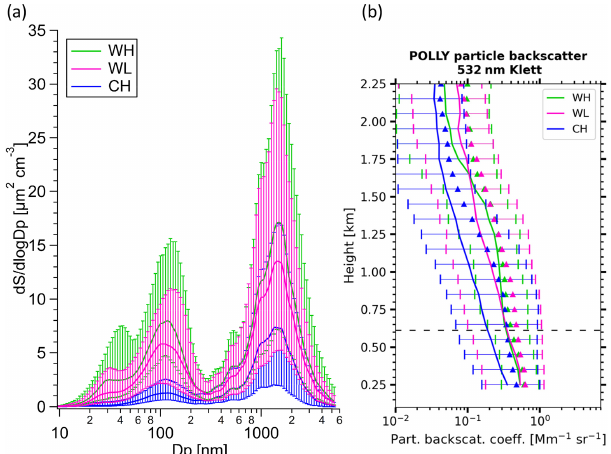
Figure 12. (a) Particle surface area size distribution for cold season high (CH, blue), warm season high (WH, green), and warm season low (WL, magenta). (b) Vertical profile of particle backscatter co- efficient during CH, WH, and WL. The triangles show the mean values, and the dashed lines show the height of the Cerro Mirador station. The solid lines in both panels show the median value, and the error bars show the 25th to 75th